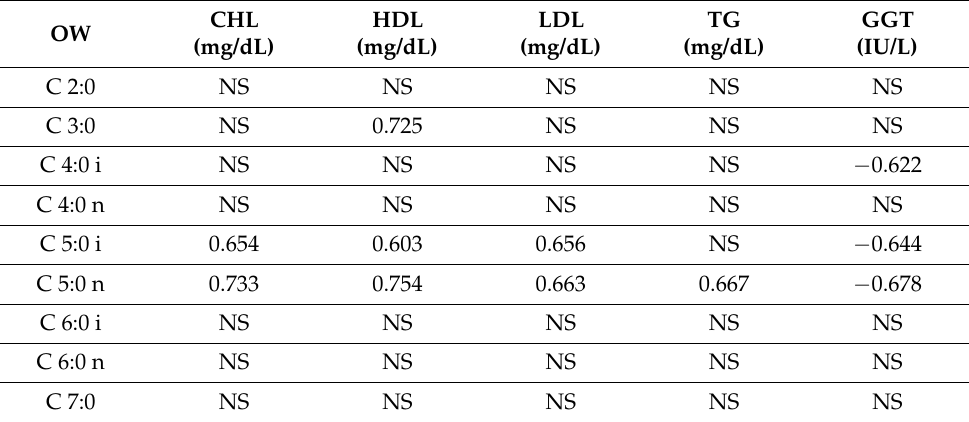
Table 3. Correlation coefficients indicating the extent to which SCFAs in the stool and the examined plasma parameters in the OW are